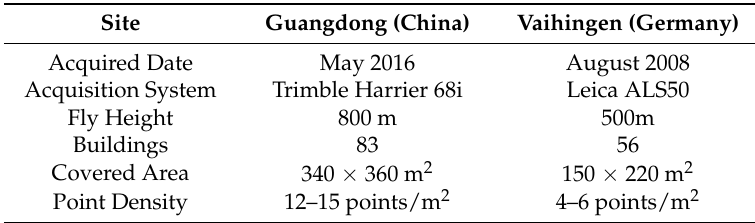
Table 2. Description of the two urban area datasets.